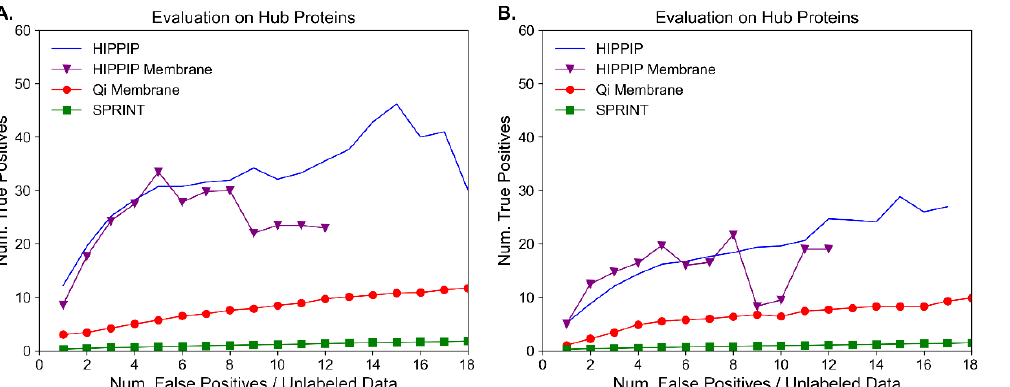
Figure 1. Evaluation of representative methods on hub proteins. Three methods (HiPPIP, that by Qi et al., and SPRINT) are evaluated on hub proteins. The figures show the cumulative number of true positives versus the number of false positives a , computed individually for each protein and then averaged for each method for each point on x-axis. The hub proteins considered are: ( A ) same proteins as originally used in HiPPIP publication, and ( B ) hub proteins with more than 100 PPIs as per currently known PPIs from HPRD and BioGRID. The labeled data used in evaluation are from HPRD and BioGRID for ( A ) and ( B ). a Note that in this scenario of proteome-wide evaluation (i.e., where a hub protein is paired with every other protein in the human proteome), the unlabeled data may not all be false-positives, and may indeed me true positives that are currently unknown. Table 1. Sizes of different datasets created for testing. Pair sizes vary for the held-out data due to the number of pairs drawn from a single bin (such as 4, 4) being half the size of drawing pairs from 2 bins (such as 3, 4). Held out test sets for 1:1 (50%) and 1:9 (10%) positive pairs use all positive data per held out